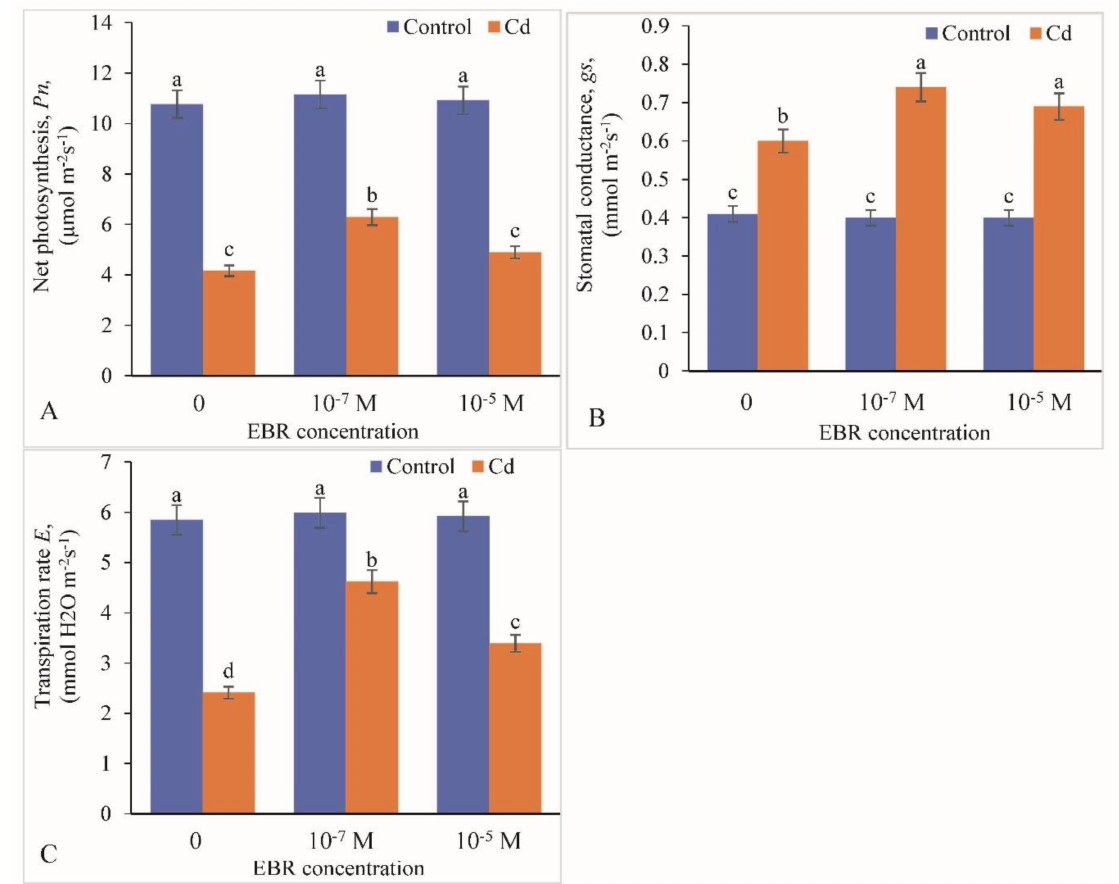
Figure 3. External supplementation of 24-Epibrassinolide maintains the ( A ) net photosynthesis, ( B ) stomatal conductance and ( C ) transpiration rate in the leaves of B. juncea under Cd (200 µ M) stress. Values with di ff erent letters above the bars are significantly di ff erent at each measured time point ( p < 0.05) (Mean ±